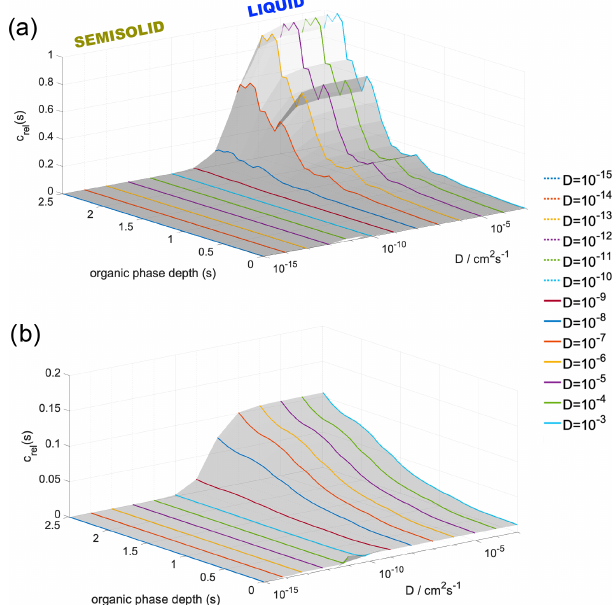
Figure 6. Modeled, diffusivity-corrected concentration gradient of water in the organic phase at (a) 300 and (b) 200K at 98% RH and at varying diffusion coefficients. Organic-phase depth describes the distance from the vapor–organic interface; zero corresponds to the Gibbs dividing surface between the vapor and particle